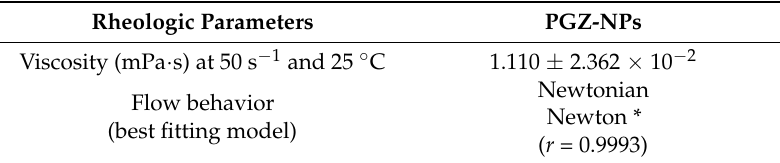
Table 3. Rheological properties of